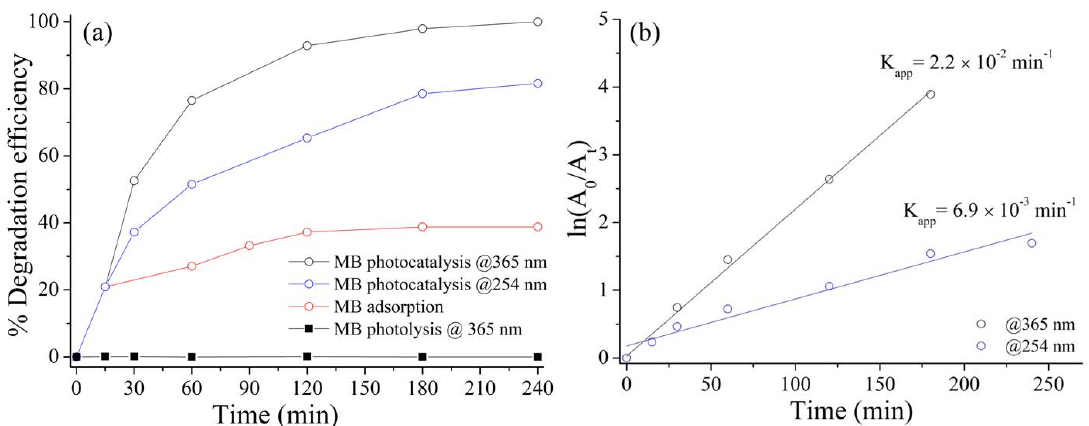
Figure5. ( a )Timeevolutionofphotocatalyticdecompositione ffi ciencyofmethyleneblueunderdi ff erent Figure 5. ( a ) Time evolution of photocatalytic decomposition efficiency of methylene blue under UV wavelength irradiation; ( b ) kinetics of photocatalytic decomposition e ffi ciency of methylene blue different UV wavelength irradiation; ( b ) kinetics of photocatalytic decomposition efficiency of under di ff erent UV wavelength methylene blue under different UV wavelength irradiation.